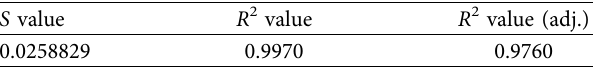
Table 20: Regression model and summary results for GRG.